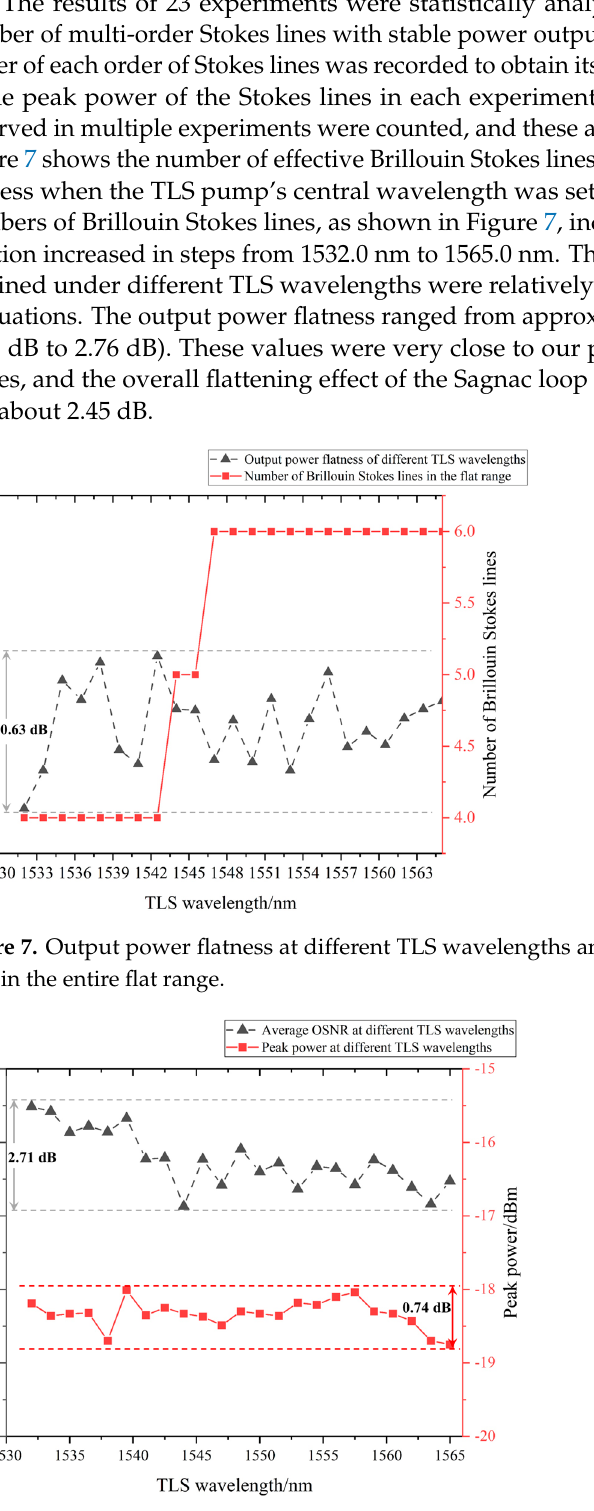
Figure 8. Brillouin Stokes lines’ average OSNR and peak power at different TLS wavelengths.